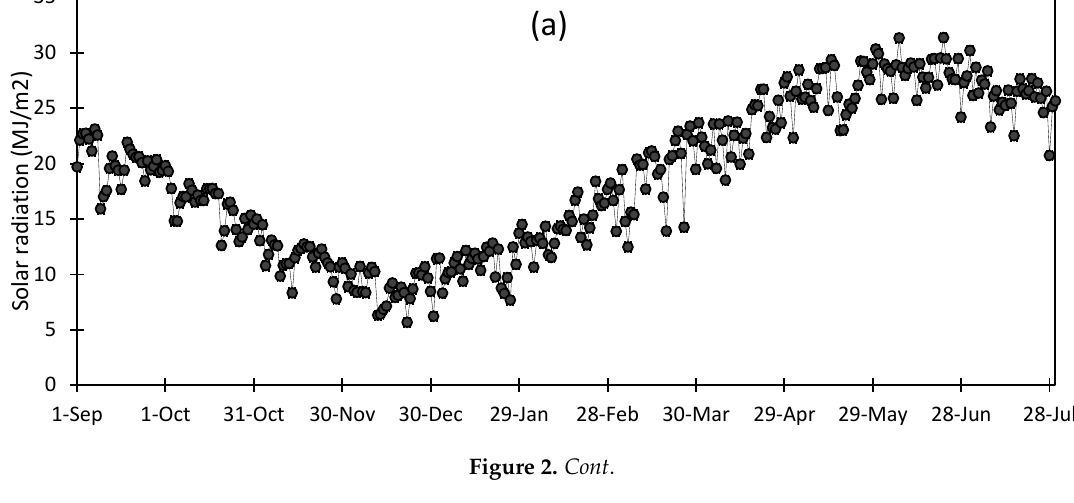
Figure 1. Trends in the ( a ) Daily average temperature and ( b ) Growing degree day and thermal unit for the period of 1st September to 31st July.